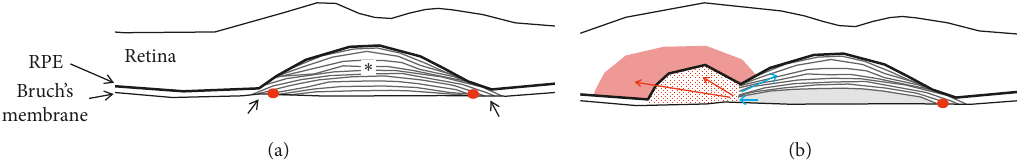
Figure 6: A schematic drawing showing the postulated developmental mechanism of subretinal hemorrhage in eyes with prechoroidal cleft. (a) The subretinal pigment epithelial (RPE) fibrovascular tissue (asterisk) firmly attaches to the Bruch’s membrane in some regions (black arrows). In these regions, new vessels in the fibrovascular tissue may also firmly attach to the Bruch’s membrane (red circles). (b) Strong sub- RPE tissue contraction or high-pressure exudation from the tissue (blue arrows) makes a force separating the sub-RPE tissue from the Bruch’s membrane, resulting in rupture of vasculature, sub-RPE hemorrhage (area filled with red dots), and subretinal hemorrhage (area filled with light